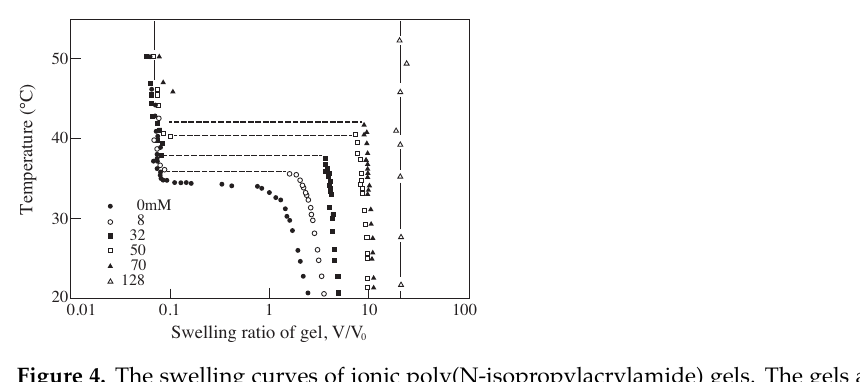
Figure 4. The swelling curves of ionic poly(N-isopropylacrylamide) gels. The gels are ionized by co-polymerization of a desired amount of sodium acrylate. Reproduced with permission from Ref. [8]. © 1986, The Physical Society of Japan.